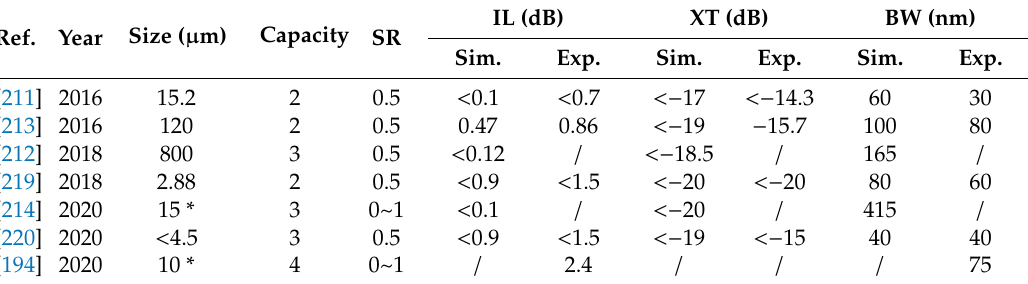
Table 7. Summary of the reported silicon multi-mode